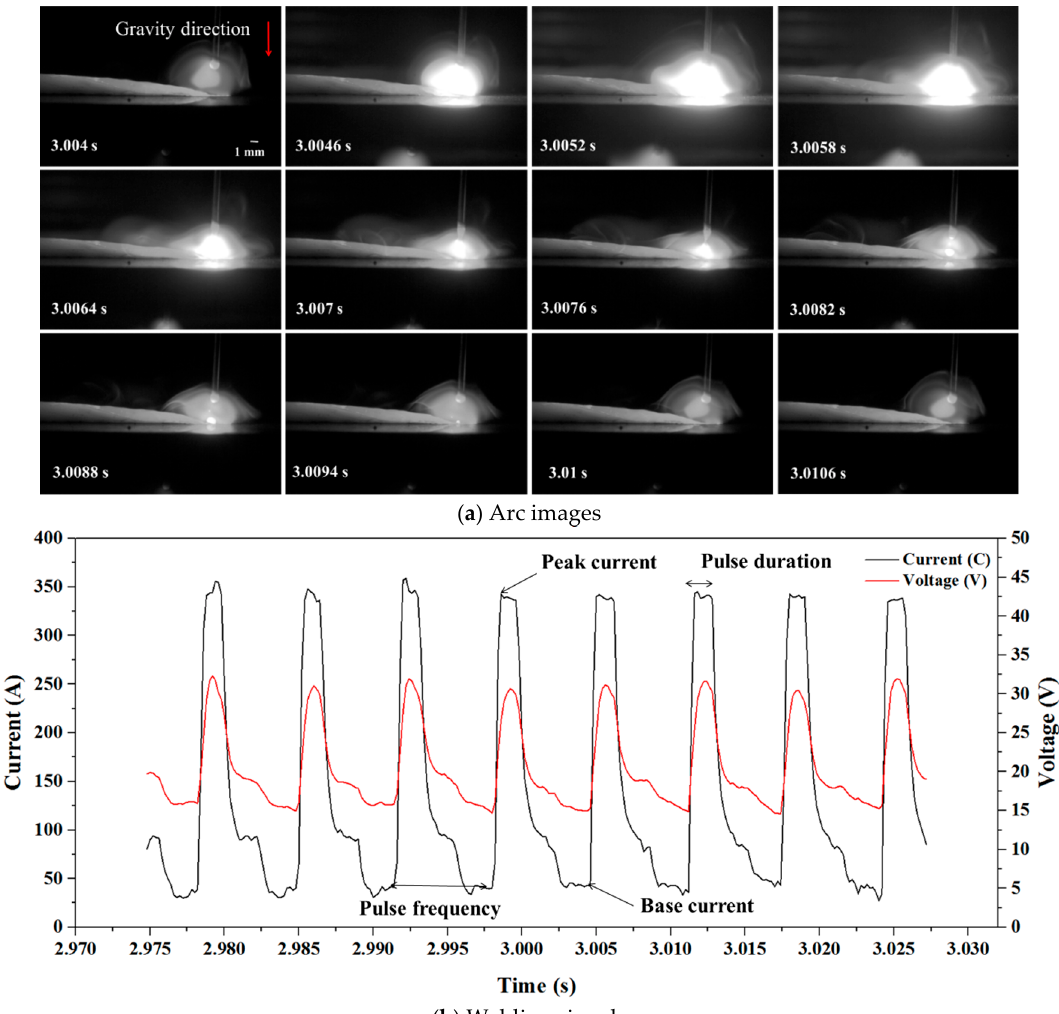
Figure 3. Synchronization of ( a ) arc images and ( b ) welding signals with a wire feed rate (WFR) of 7 m/min.